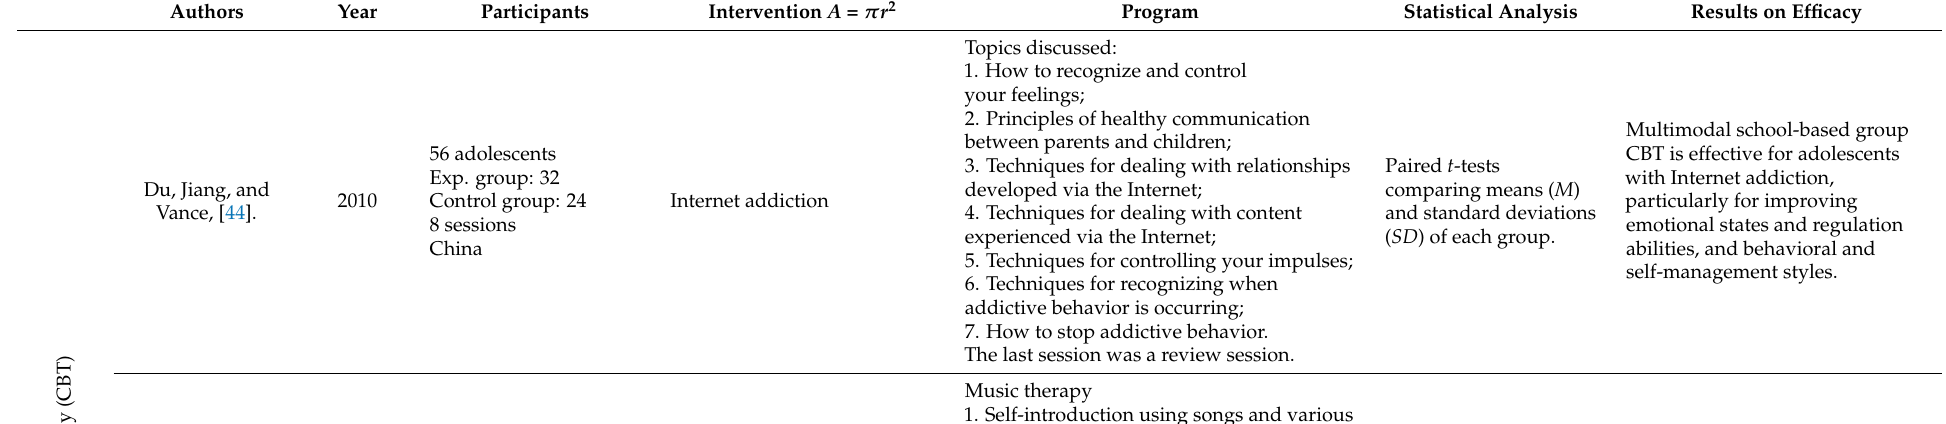
Table 1. Summary of selected